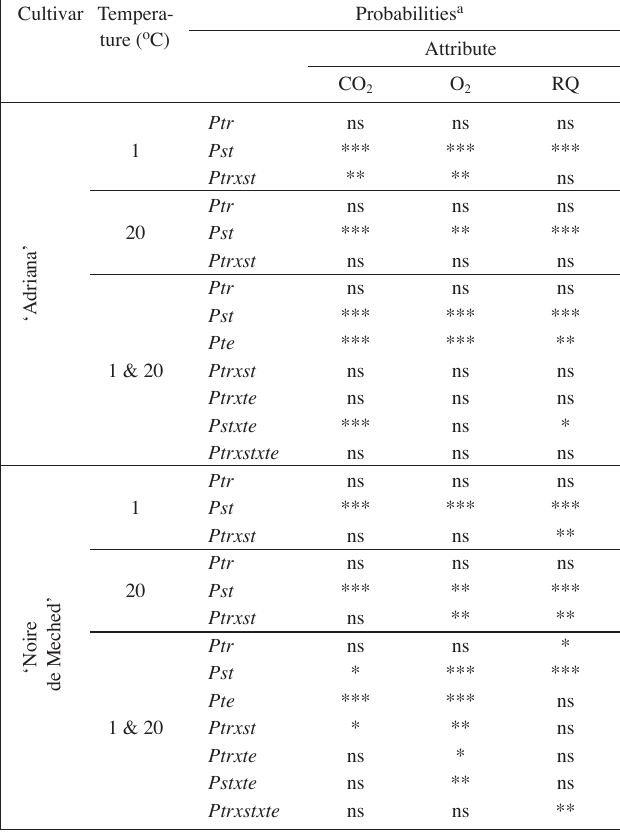
Tab. 2: Probabilities of the effects of rain cover treatment ( Ptr ), storage time ( Pst ), temperature ( Pte ) and their interactions on CO 2 production and O 2 uptake rates and on RQ in ‘Adriana’ and ‘Noire de Meched’ cherries at harvest at 20 o C, during storage at 1 o C and after storage